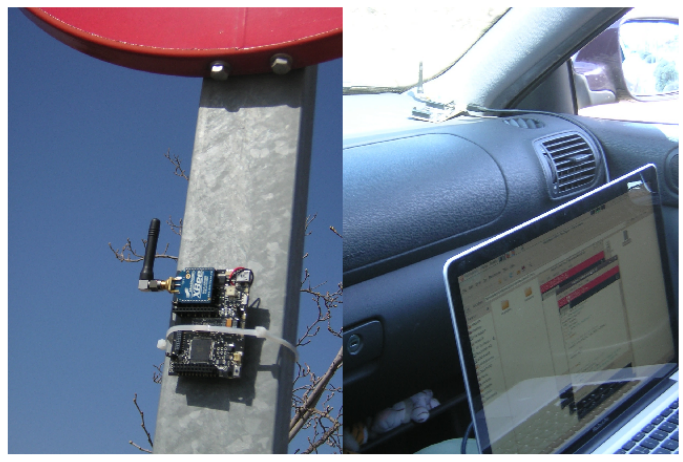
Figure 13. ( Left ) Waspmote transmitter installed on a signal. ( Right ) Waspmote receiver in the